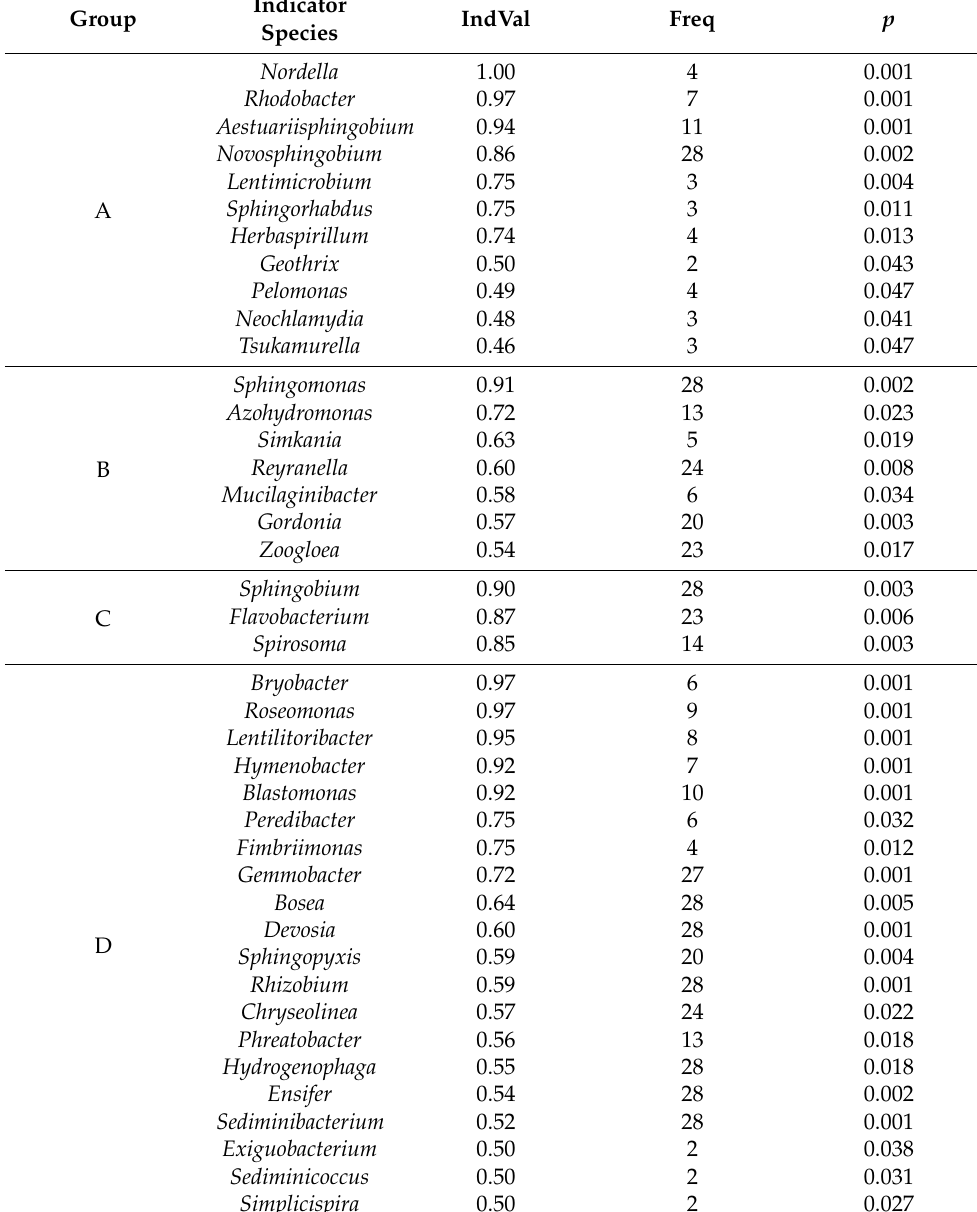
Table 2. Indicator species (or taxa) of bacterial community for five groups from cluster